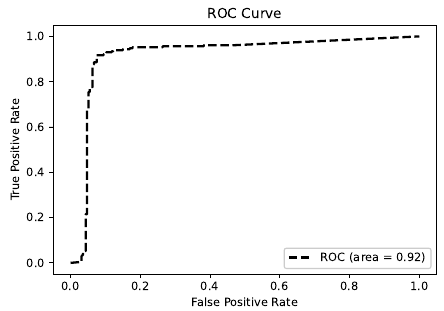
Figure 11. Classification of roc curves.